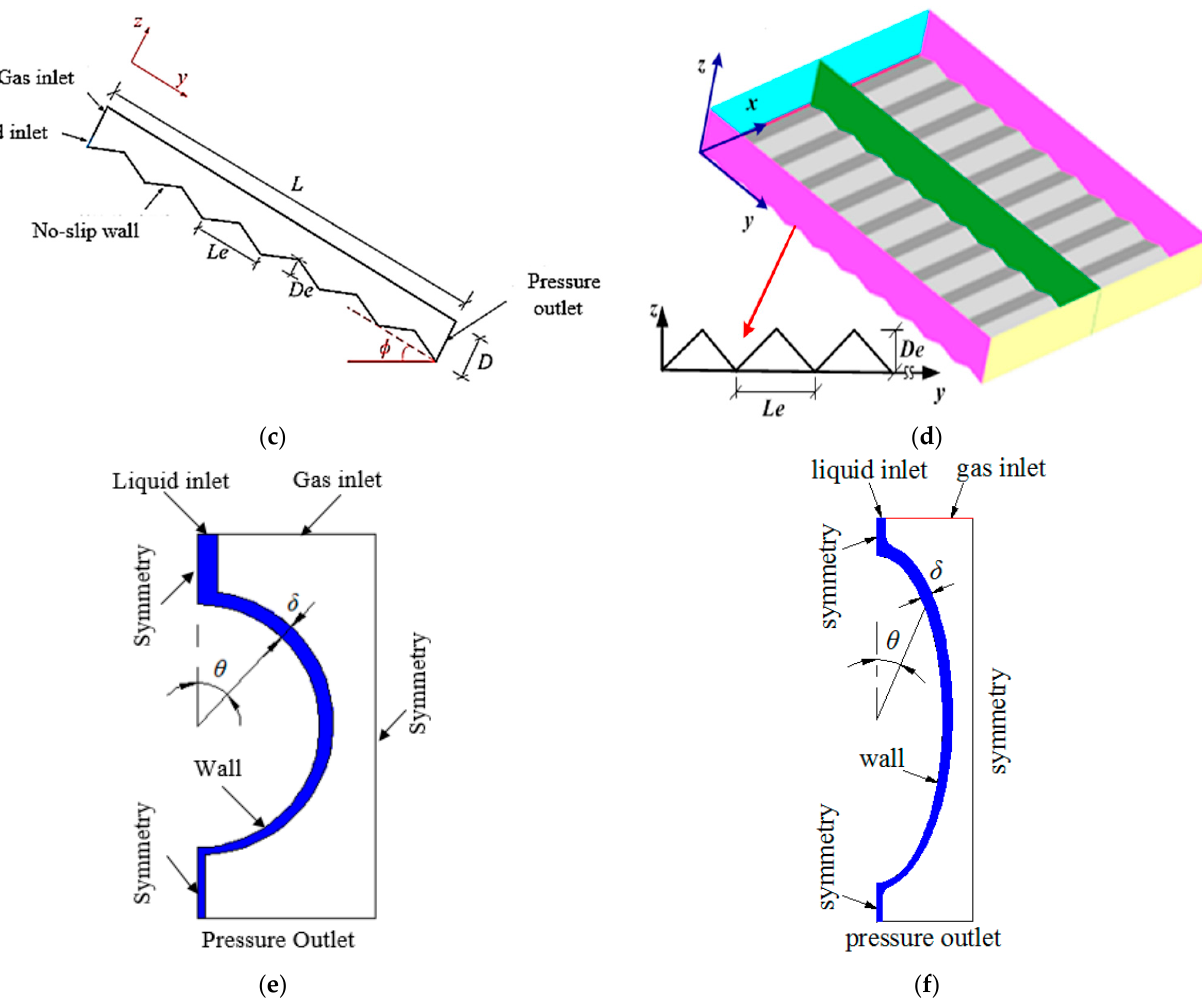
Figure 1. The physical models of different structures: ( a ) 2D smooth plate; ( b ) 3D smooth plate; ( c ) 2D triangular corrugated plate; ( d ) 3D triangular corrugated plate; ( e ) round tube; and ( f ) elliptical tube.